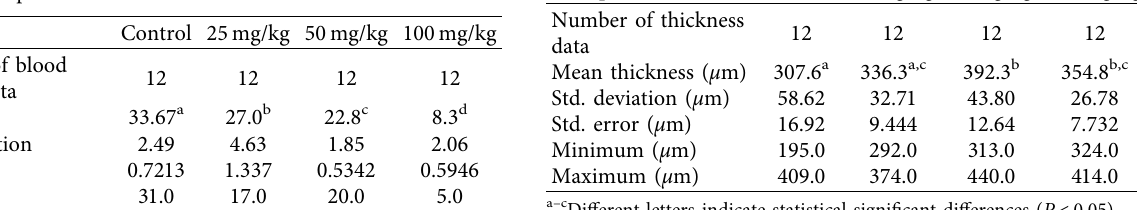
Figure 5: Bar chart showing mean values of the number of blood vessels in the dental pulp of Wistar rats after 60 days of CaO-NP administration at different dosages (25, 50, and 100mg/kg) and the nontreated control group. Horizontal lines connecting two bars indicate statistical significance ( P < 0 . 05). Table 2: Mean values of the number of blood vessels in the dental pulp of Wistar rats after 60 days of CaO-NP administration at different dosages (25, 50, and 100mg/kg) and the nontreated control group.